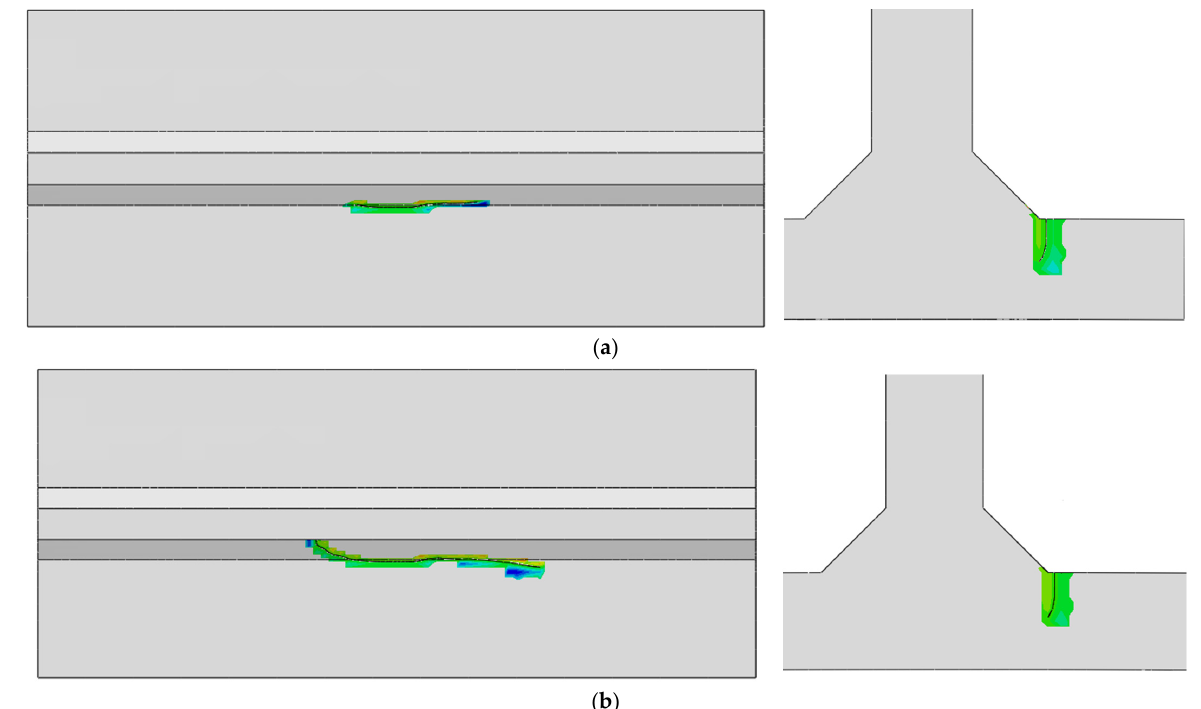
Figure 17. Crack propagation under a maximum displacement of 0.4 mm: ( a ) without residual stress field at 31,514 cycles; ( b ) with residual stress field at 9618 cycles.